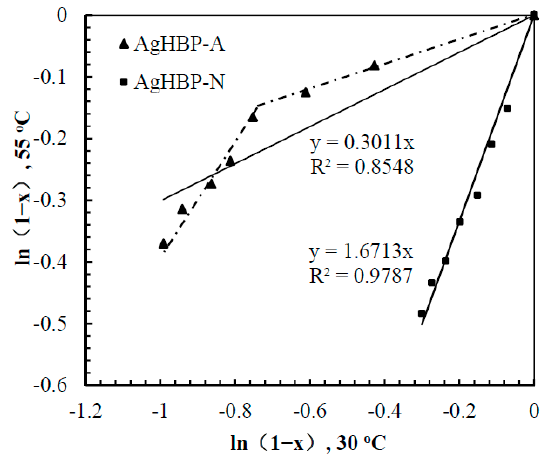
Figure 8. Kinetic fitting of the catalytic activities of the prepared polymer reactors (MB initial concentration, 2.6 µmoL·mL − 1 ; polymer reactors, 1.5 mg·mL − 1 ).